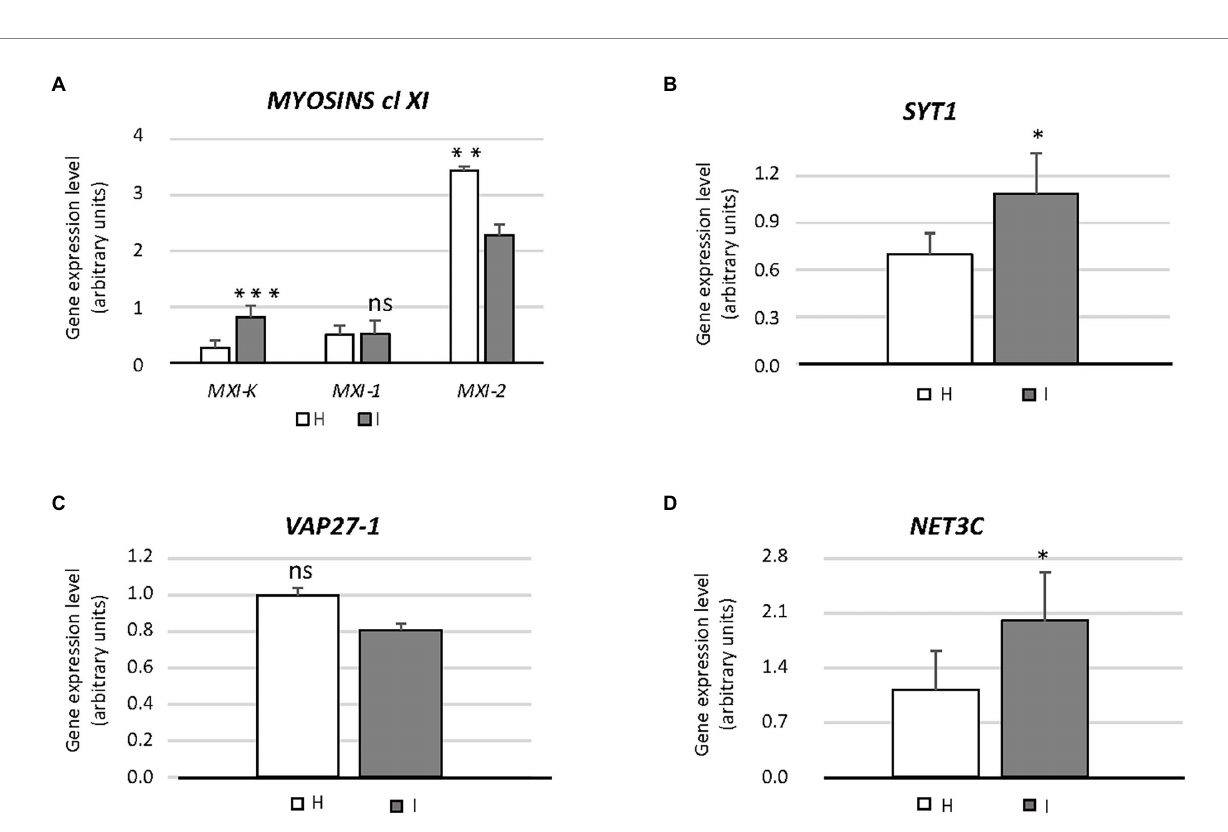
FIGURE 3 Expression of genes involved in endoplasmic reticulum architecture ( MXI-K , MXI-1 , MXI-2 , SYT1 , VAP27-1 , NET3C ) (A–D) in healthy and infected midrib tissue. Expression values were normalized to the UBC9 transcript level, arbitrarily fixed at 100, then expressed as gene expression level (which corresponds to mean normalized expression, MNE) ± SD. At least five individuals (and three technical repeats of PCR reaction) were used for MNE determination of each gene in both healthy (H) and infected (I) plants. Statistical analyses were performed using an unpaired t -test. Family-wise significance and confidence level = 0.05 (* p < 0.05, ** p < 0.01, *** p < 0.001, ns: not